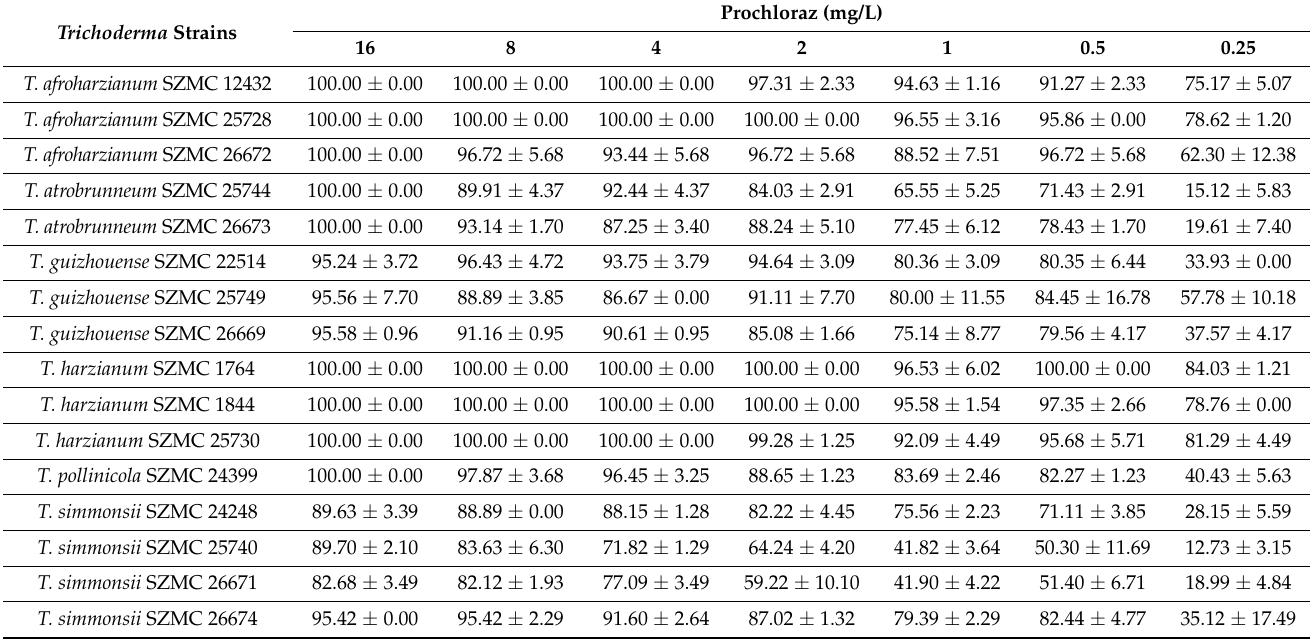
Table 4. Inhibitory effect of prochloraz on the mycelial growth of Trichoderma strains isolated from mushroom production (GI, %).